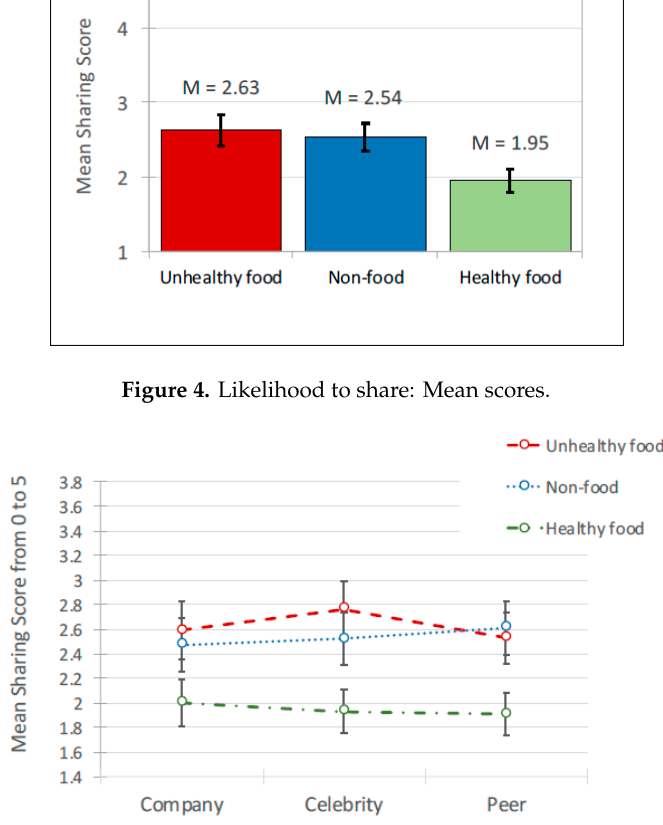
Figure 5. Interaction between Likelihood to Share and source of ad for 3 types of ad.